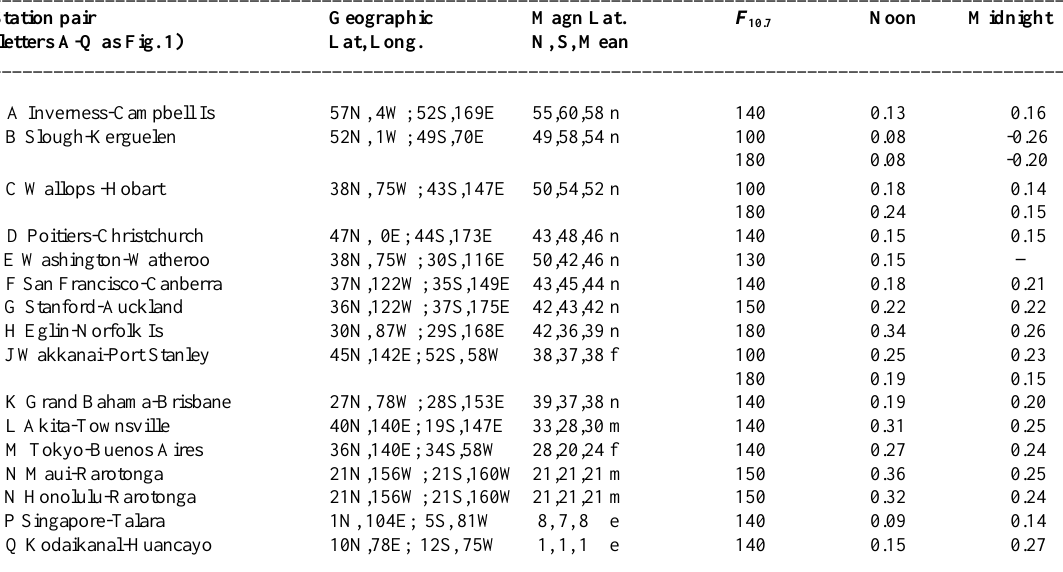
Table 1. Annual asymmetry of N mF2 from ionosonde and total content data. Magn. Lat. is absolute values of Corrected Geomagnetic Latitude.